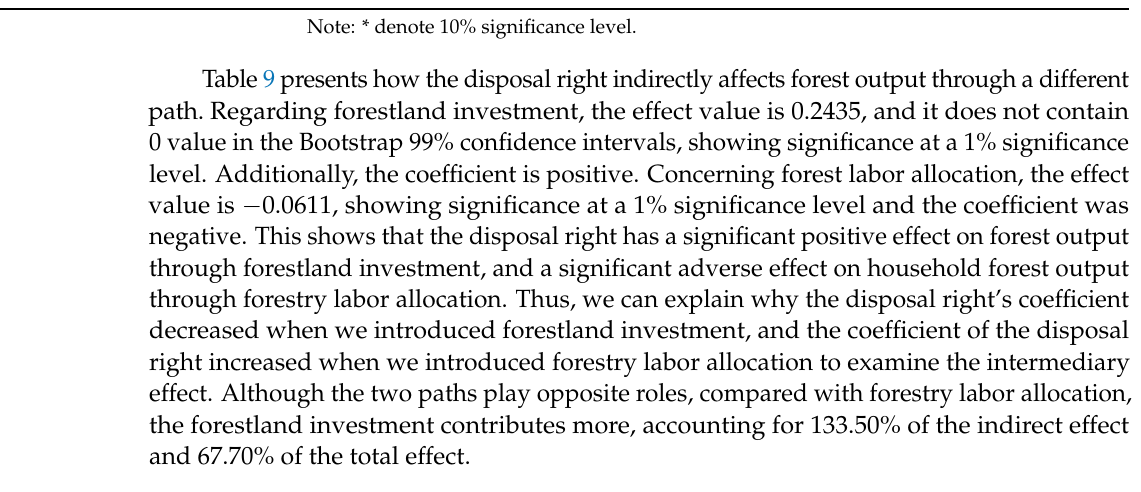
Table 9. Analysis of the indirect effect of disposal right on forest